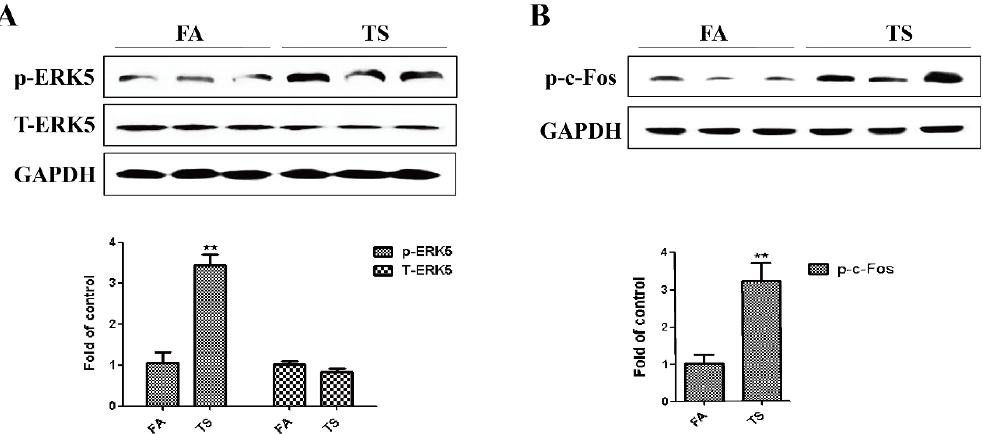
Figure 2. Tobacco smoke increased ERK5 activation in the stomach tissues of mice. ( A ) Western blotting analyses of phosphorylated ERK5 and total ERK5 in the stomach of mice exposed to tobacco smoke for 12 weeks; ( B ) Western blotting analyses of phosphorylated c ‐ Fos in the stomach of mice. Data are expressed as mean ± SD. ** p < 0.01, compared with control. FA = filtered air; TS = tobacco smoke.